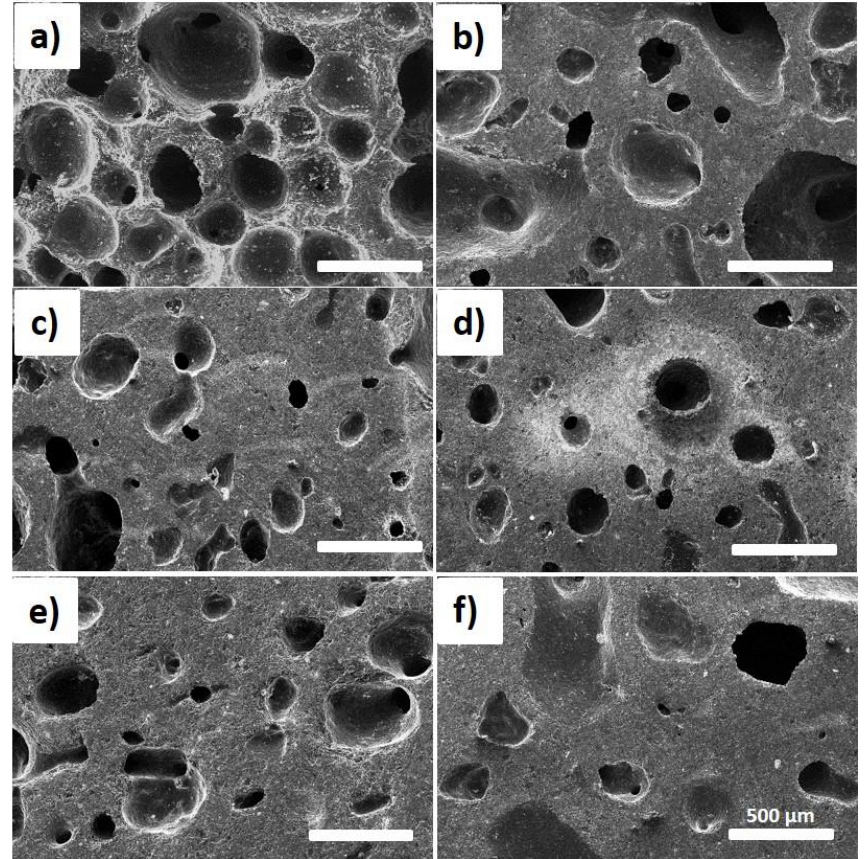
Figure 4. SEM images of pristine CF from raw CTP and as-prepared mCF materials from modified CTP. ( a ) pristine CF from CTP. ( b – f ) are sample mCF-1, mCF-3, mCF-5, mCF-7 and mCF-9 resulting